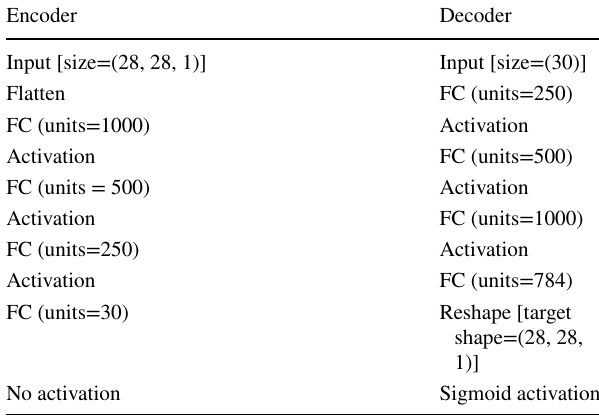
Table 1 Autoencoder architecture for 1-channel image